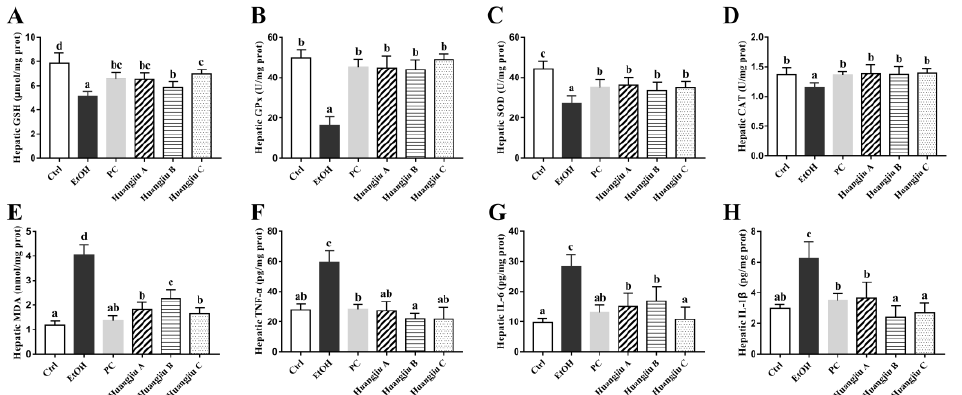
Figure 2. Effects of Huangjiu interventions on hepatic oxidative stress parameters ( A – E ) and inflam- matory indicators in mice ( F – H ). ( A ) Hepatic GSH level. ( B ) Hepatic GPx activity. ( C ) Hepatic SOD activity. ( D ) Hepatic CAT activity. ( E ) Hepatic MDA level. ( F ) Hepatic TNF- α level. ( G ) Hepatic IL-